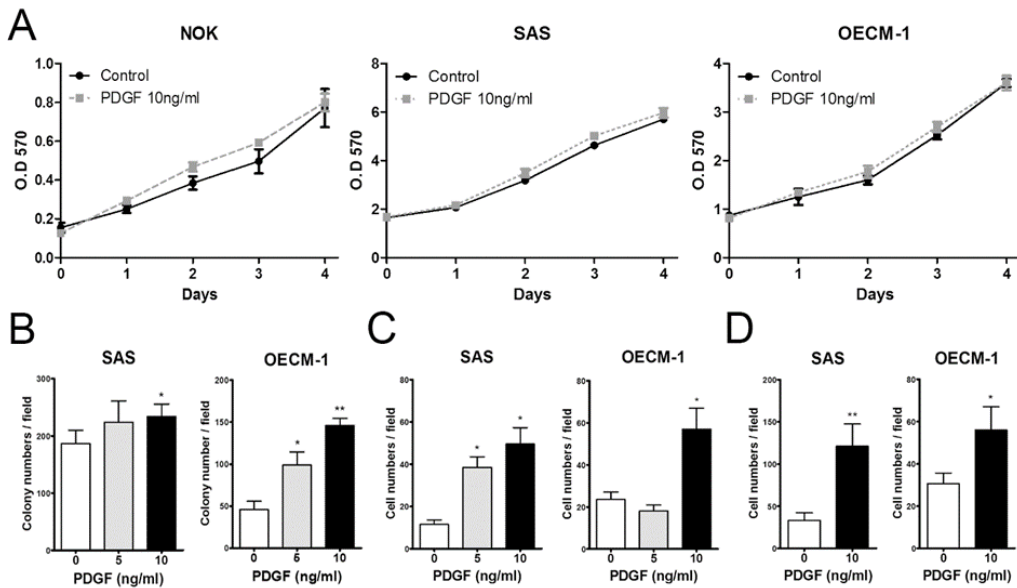
Figure 6. Association between PDGF treatment and oncogenic phenotypes in HNSCC cells. ( A ) The 9 effect of PEGF treatment on NOK, SAS, and OECM ‐ 1 cell proliferation was examined. ( B ) 10 Anchorage ‐ independent colony formation; ( C ) migration assay; and ( D ) invasion assay. *, p < 0.05; **, 11 p < 0.01 12